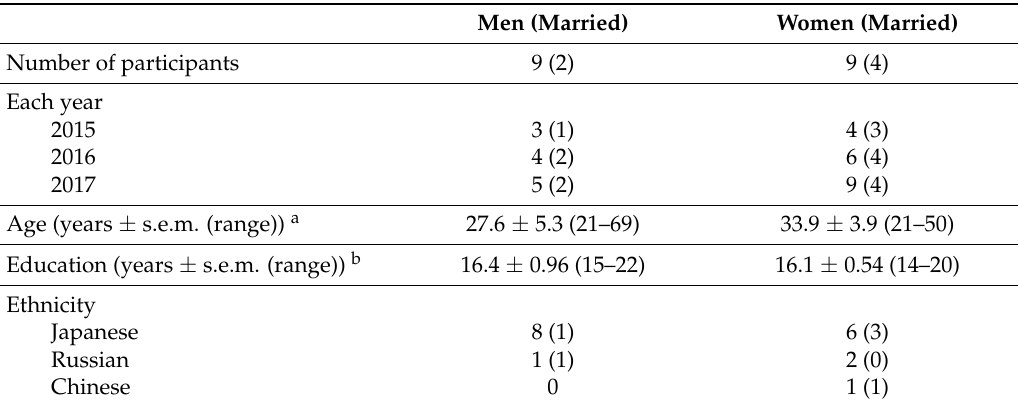
Table 1. Demographic